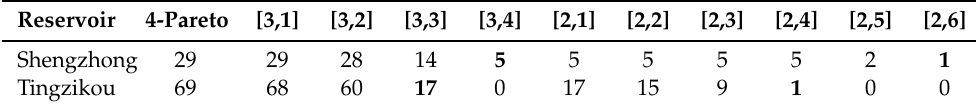
Table 6. Preferred alternatives resulting from the SEABODE approach.